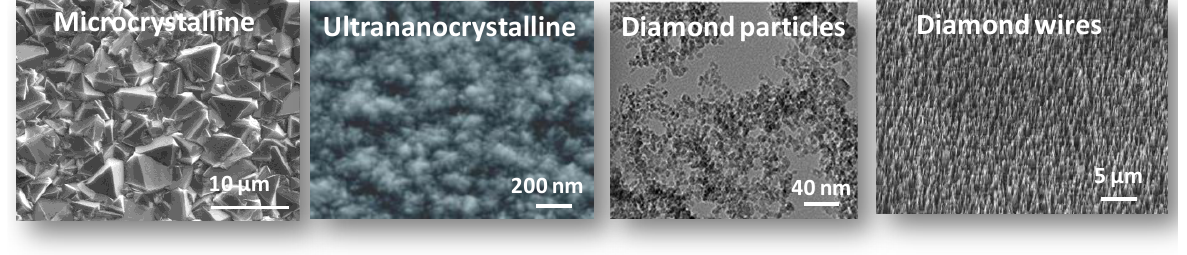
Figure 2. Different morphologies and forms of